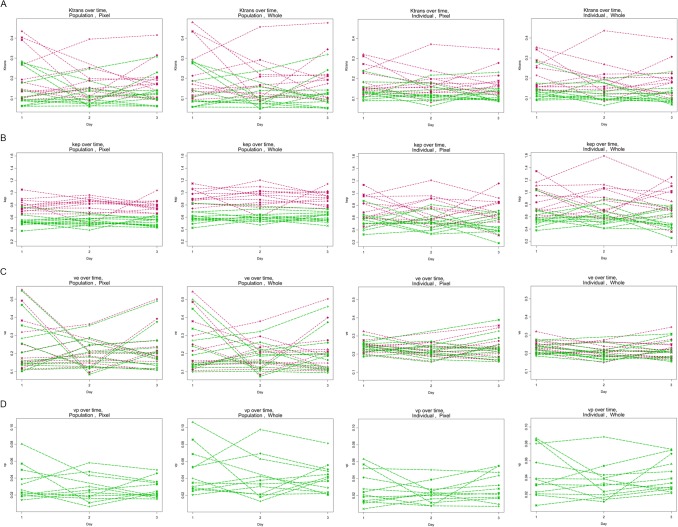
Scatter plots of 3 day time points, of horizontal row a) K
trans, b) k
ep, c) v
e, d) v
p, by 2- (red lines) vs. 3-parameter (green lines) models; with separate plots for pixel-by-pixel vs. whole tumor analyses, and by individual- vs. population-based VIFs.Y-axes for K
trans and k
ep in min-1: v
e and v
p, unitless. Note: v
p can only be derived with the 3-parameter model. (Note: one missing data point for one rat)